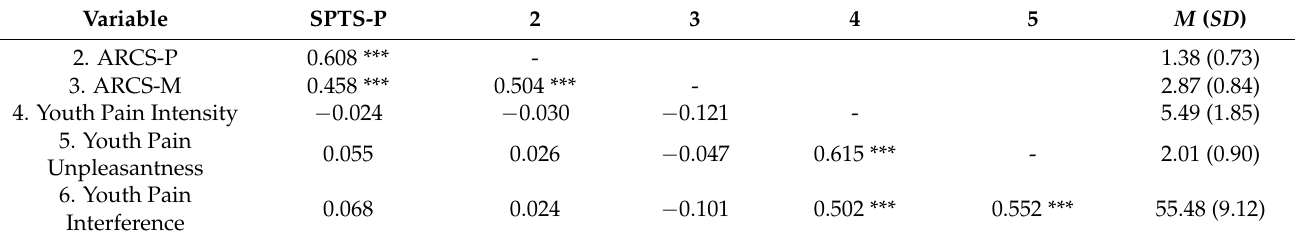
Table 5. Means ( M ), standard deviations ( SD ), and Spearman correlations among the SPTS-P and measures for construct